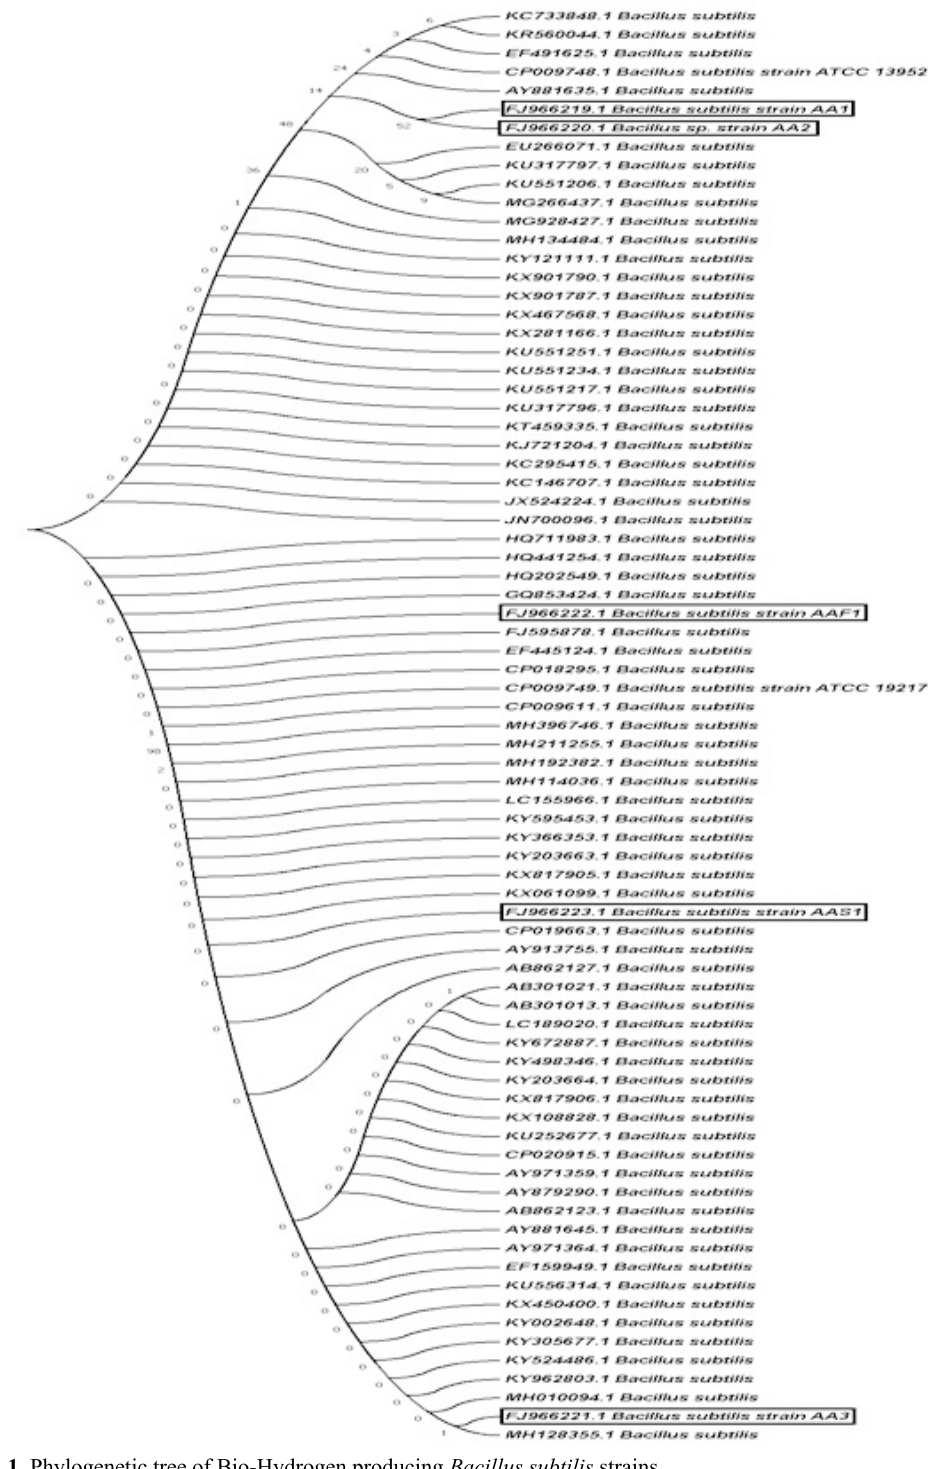
Fig. 1. Phylogenetic tree of Bio-Hydrogen producing Bacillus subtilis